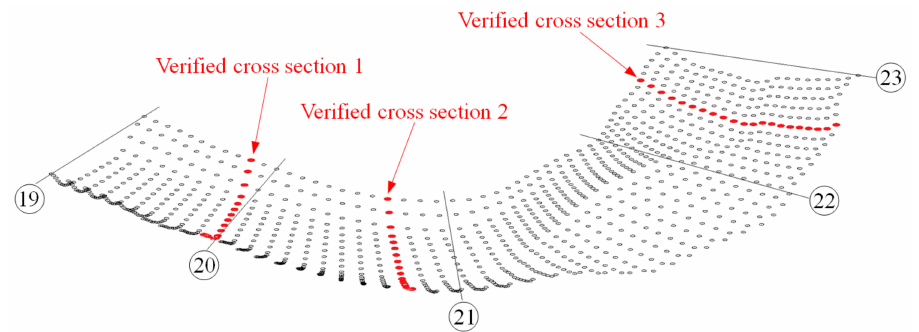
Figure 7. Riverway scattered digital